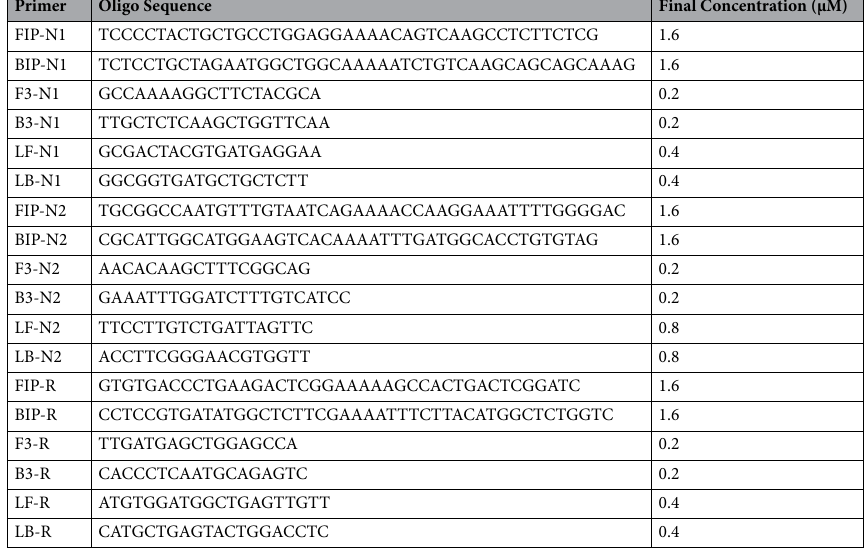
Table 1. Multiplex primer sequences used in SaliVISION RT-LAMP assay for SARS-CoV-2